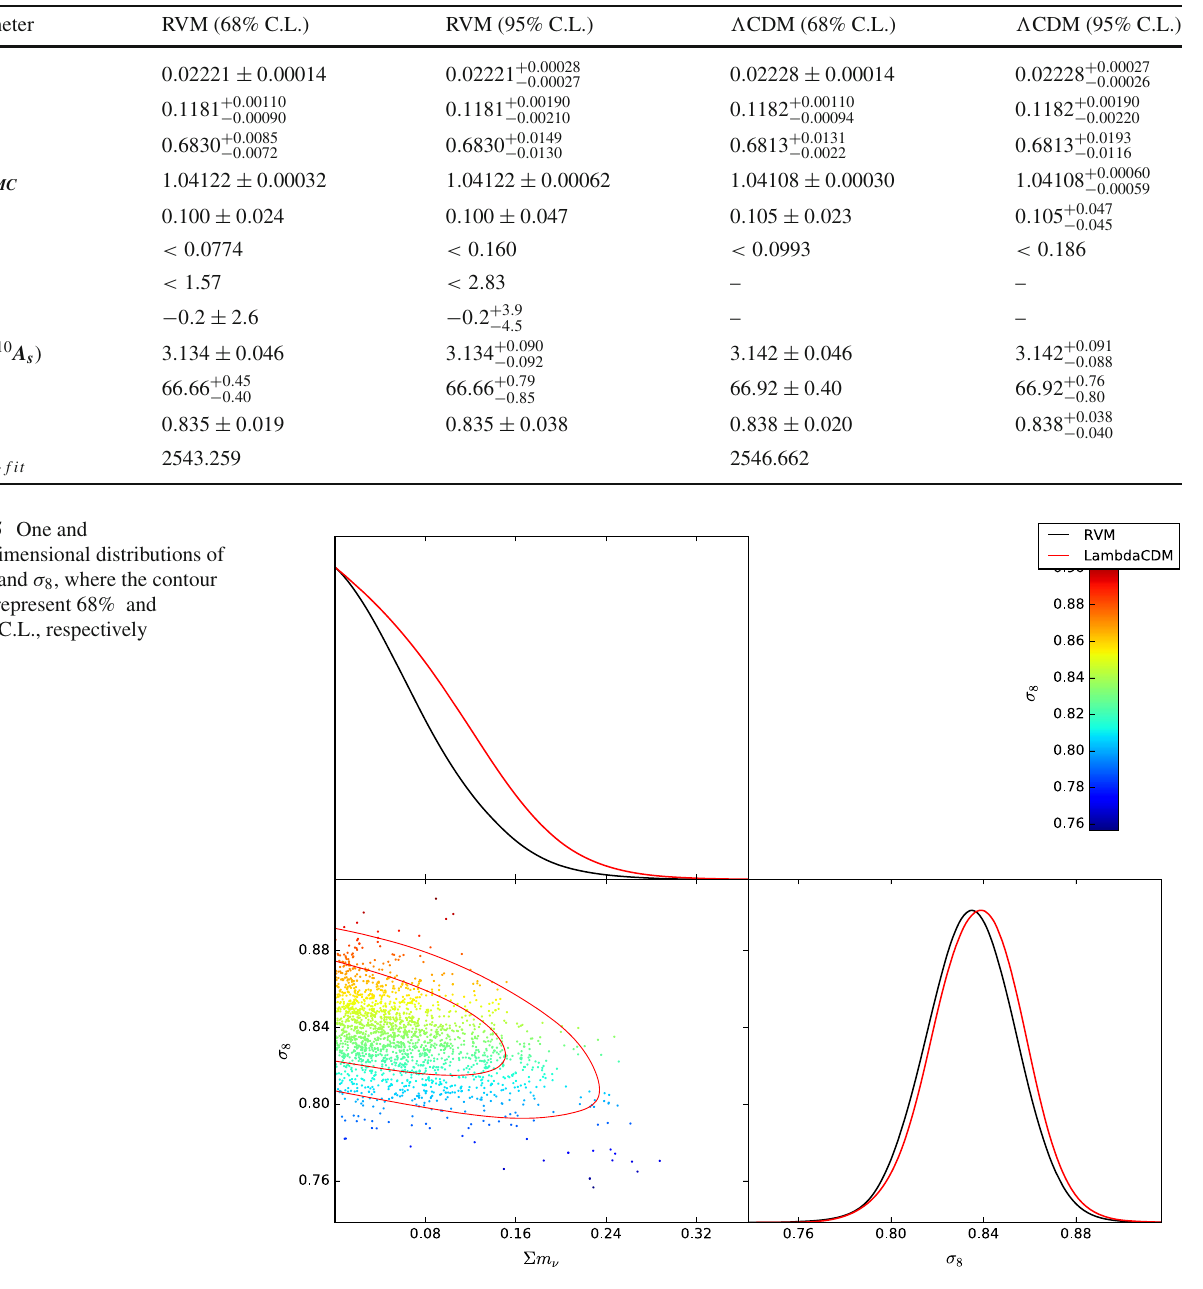
Table 3 Fitting results for the RVM and (cid:2) CDM, where the limits are given at 68% and 95% C.L., respectively Parameter RVM (68% C.L.)